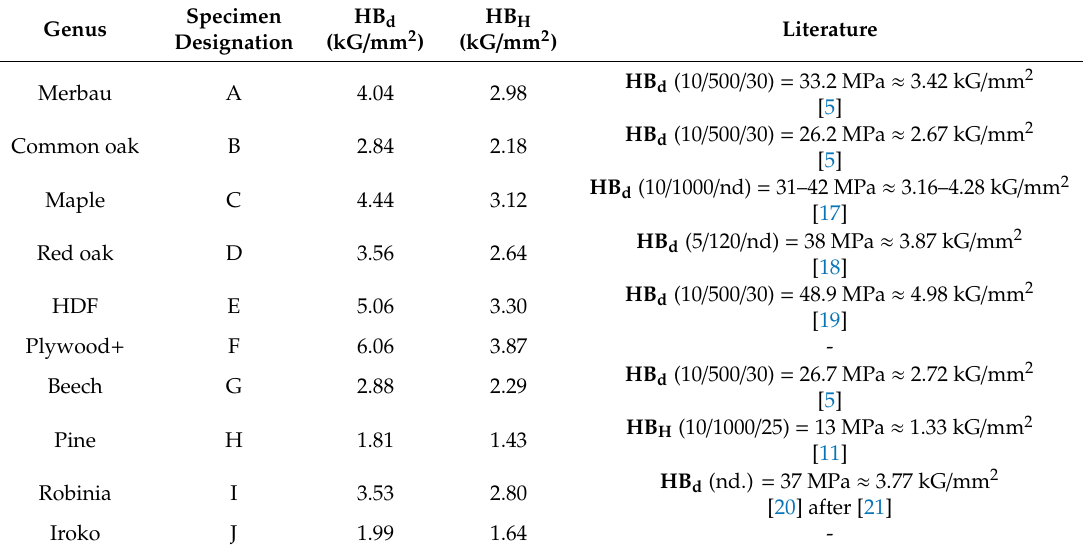
Table 6. Comparison of the tests results with